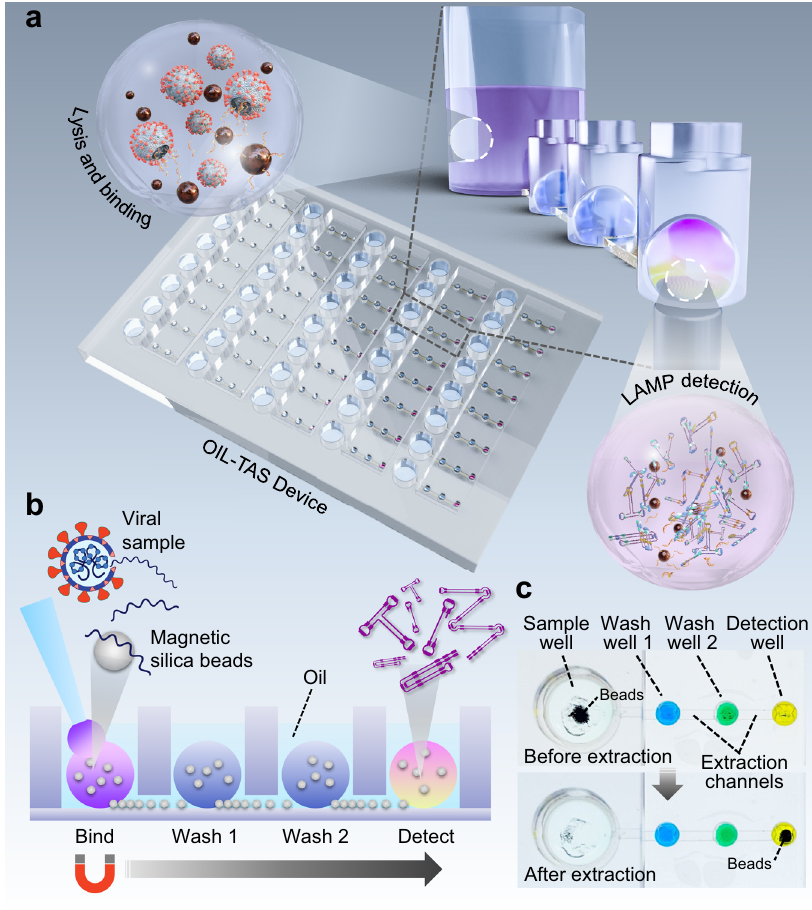
Fig. 1 Integrated RNA extraction and detection with the OIL-TAS assay. a Schematic depicting the design and essential components of the OIL-TAS. b Side view cartoon illustrating the operation principle of OIL-TAS sample extraction. Owing to the exclusive liquid-repellent (ELR) nature of the device surface, droplets appear spherical which minimizes contact with the device surface and hence biofouling-associated sample loss. c Images of a single unit of the OIL-TAS device before and after extraction. Each unit includes a large sample well for sample lysis and binding, followed by two washing wells and a detection well. Interconnecting the wells are oil- fi lled extraction channels. Wells are fi lled with droplets of food coloring for